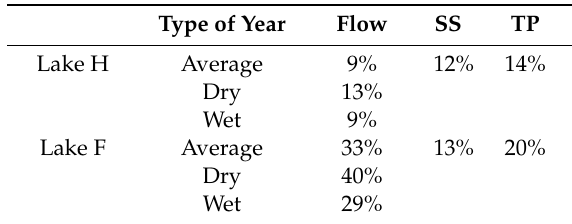
Table 2. Contribution of secondary